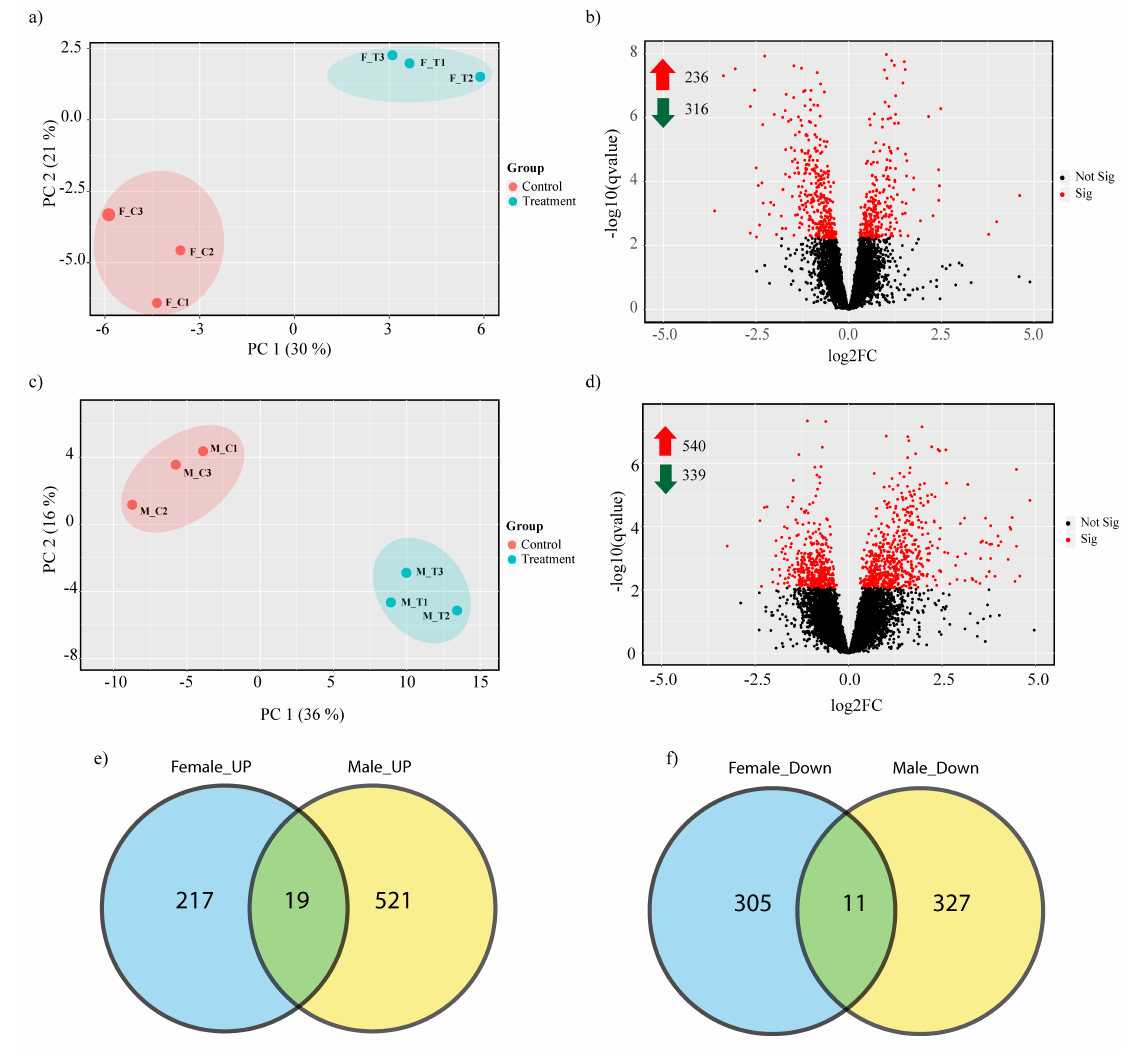
Figure 1. Summary of the transcriptome analysis: ( a ) PCA of female group samples; ( b ) volcano plot showing the number and distribution of significantly di ff erentially expressed genes in the female group; ( c ) PCA of male samples; ( d ) volcano plot showing the number and distribution of significantly di ff erentially expressed genes in the male group; Venn diagrams showing di ff erentially expressed genes DEGs common between male and female groups: ( e ) up-regulated and ( f )